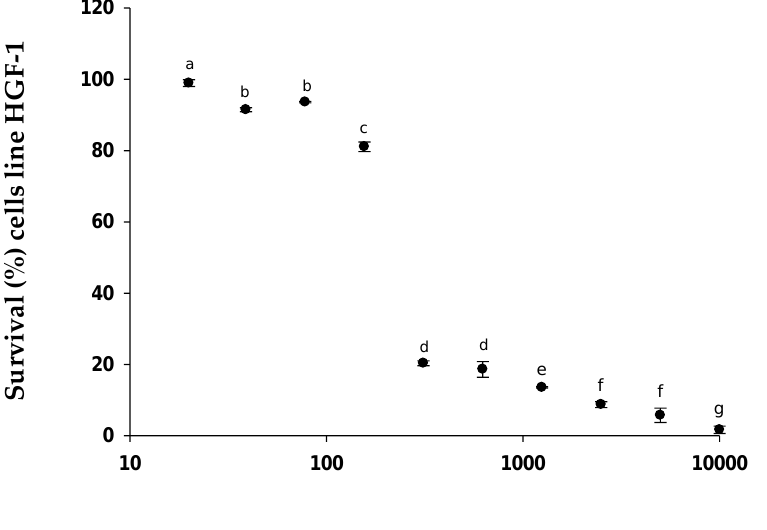
Figure 7. % Survival of cell line HGF-1 (human gingival fibroblasts), low proliferative, exposed to different concentrations of EgPs. Similar letters (a to g) indicate that there are no significant differences (Tukey, p < 0.05) between the different concentrations.